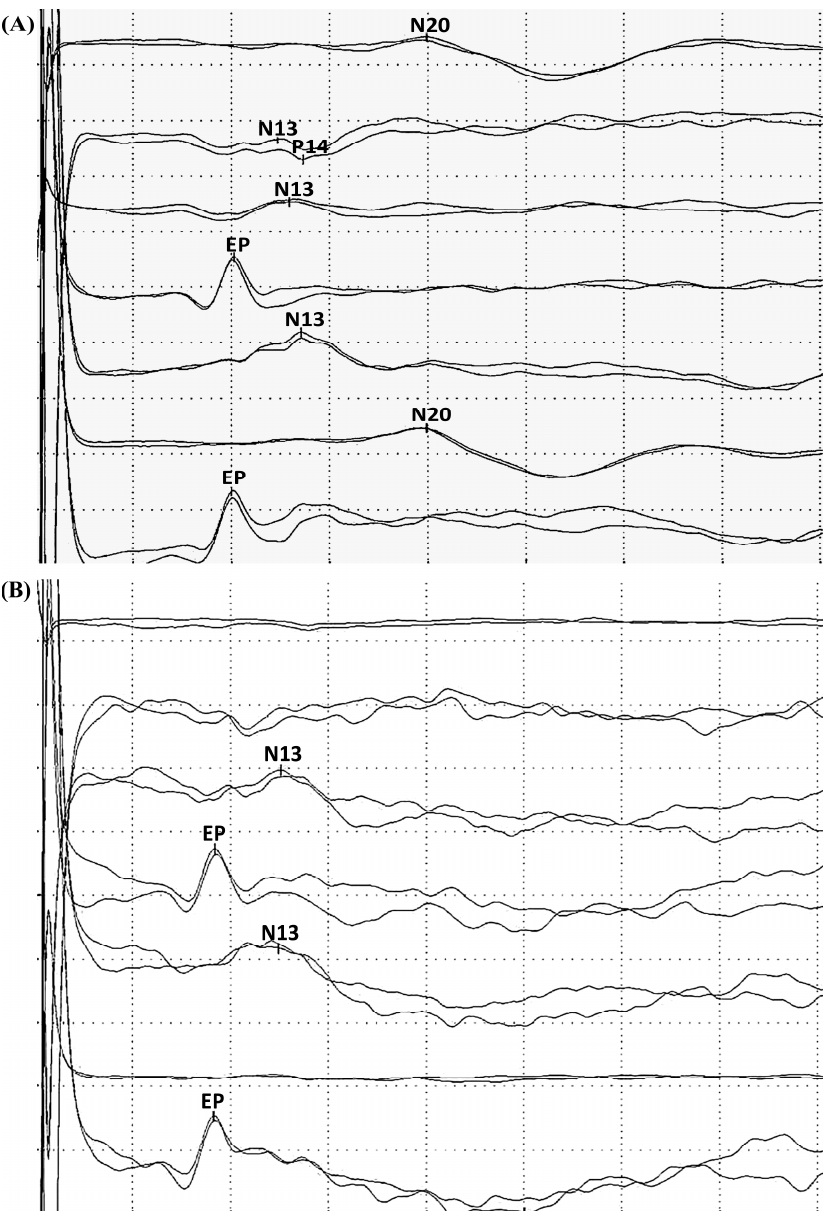
Figure 3. Example of ( A ) normal somatosensory evoked potentials (SSEPs) cortical N20 response to median nerve stimulation, demonstrating the integrity of the somatosensory pathway; and ( B ) SSEPs with absent N20, which has been regarded as a reliable predictor for poor outcome in patients after